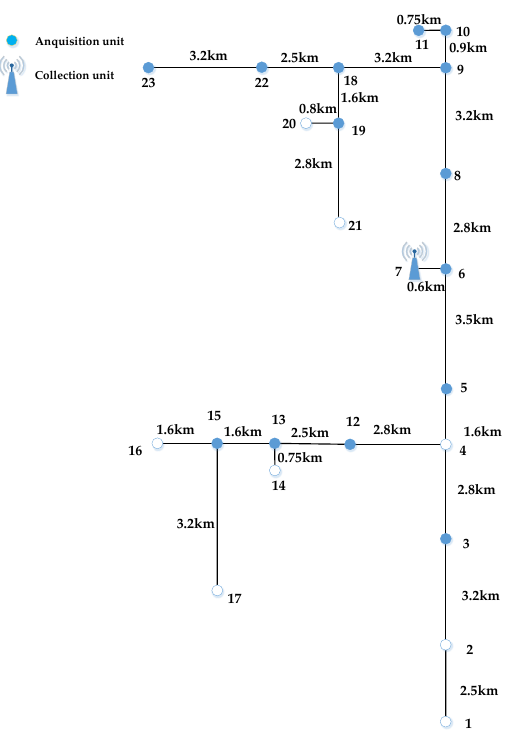
Figure 6. The installation position of IoT-based fault indicator.